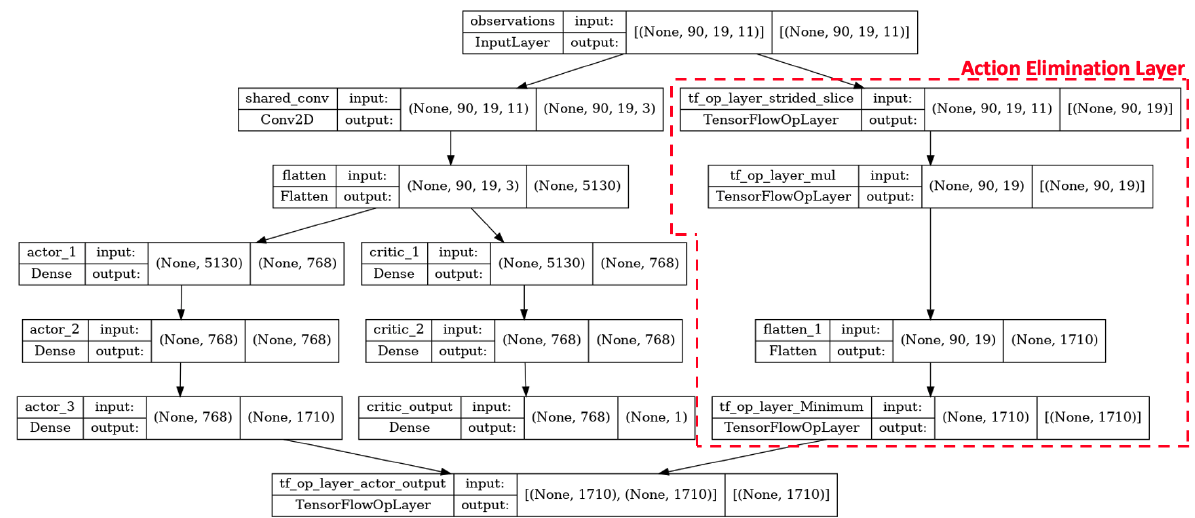
Figure 5. Neural network architecture for Dense-v1 deep reinforcement learning agent.